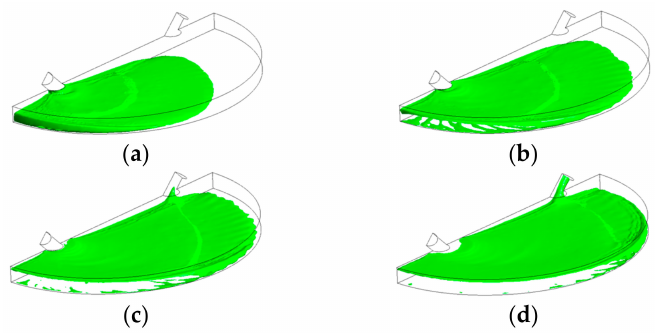
Figure 5. Free-surface during chamber flooding at the following times: ( a ) 0.8 s < τ c ; ( b ) 1.2 s < τ c ;